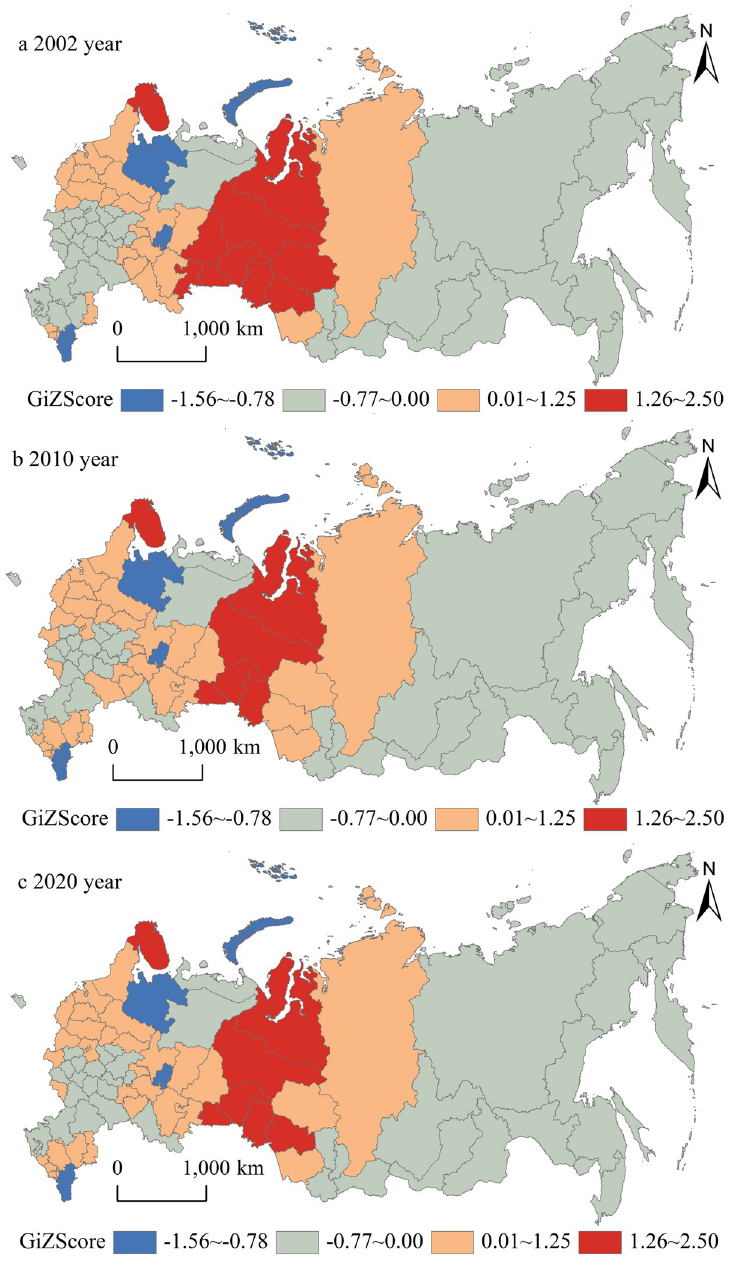
Fig 5. Spatial pattern of local hot-cold regions changes in the Russian Federation from 2002 to